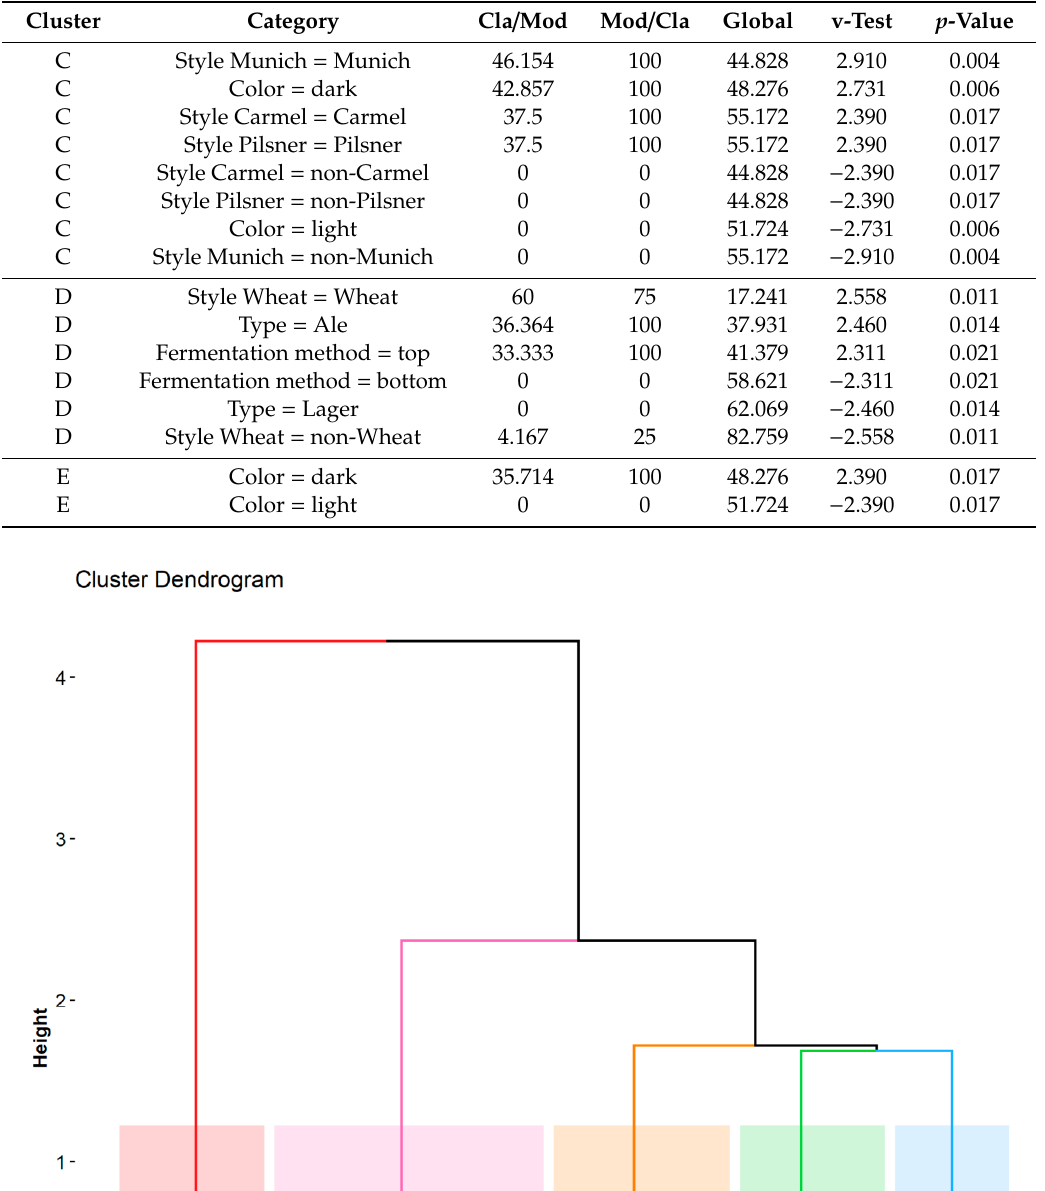
Table 6. Results for the hierarchical clustering on principal components. Description of each cluster by quantitative variables. Only variables that characterize each cluster are shown ( p -value < 0.05). Values of the v-test are sorted from strongest to weakest significance in the construction of the given cluster, i.e., the higher the positive or the lower the negative value is the better/stronger description of the cluster it has. Table 5. Cont .